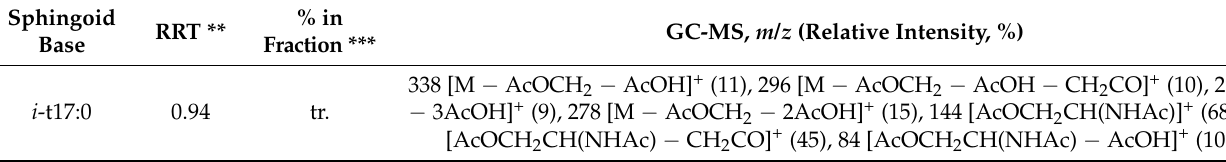
GC-MS, m / z (Relative Intensity, %)